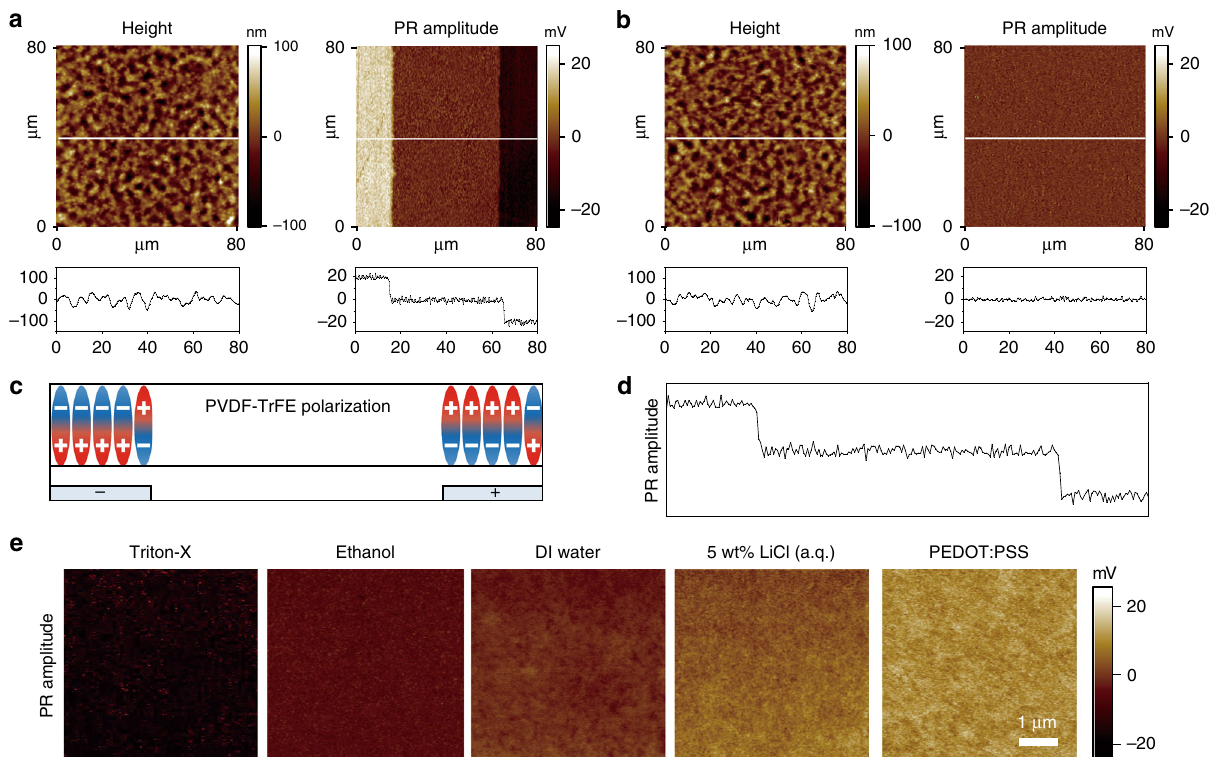
Fig. 3 Vertically aligned ferroelectric polarisation of the PVDF-TrFE fi lm. Piezoresponse Force Microscopy ( PFM) images in height and piezoelectric amplitude contrast of a PVDF-TrFE layer in the liquid-interactive ferroelectric sound (LIFS) alternating current (AC) device after direct current (DC) poling between the two in-plane electrodes with ( a ) and without ( b ) a top conductive layer. Distinct piezoelectric amplitudes with opposite contrasts are apparent in the two overlapped regions between the top conductive layer and one of the two electrodes. c Schematic of the ferroelectric dipoles of a PVDF-TrFE layer developed in the two overlapped regions under DC poling between the two in-plane electrodes. d Amplitude pro fi le along the horizontal line in a across the two overlapped regions. e PFM images in the piezoelectric amplitude contrast of PVDF-TrFE layers programmed with fi ve liquids having different dielectric constants placed on the PVDF-TrFE fi lm in an LIFS AC Supplementary Fig. 19. The fi ve representative liquids with dif-